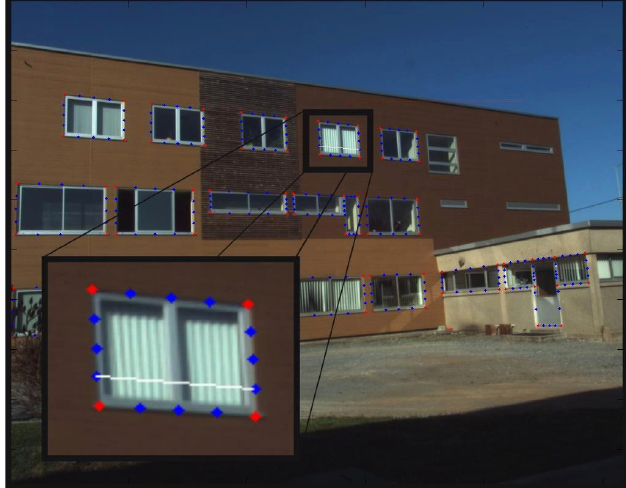
Fig. 13. Picture of the building for windows and blinds opening detection, example: closed